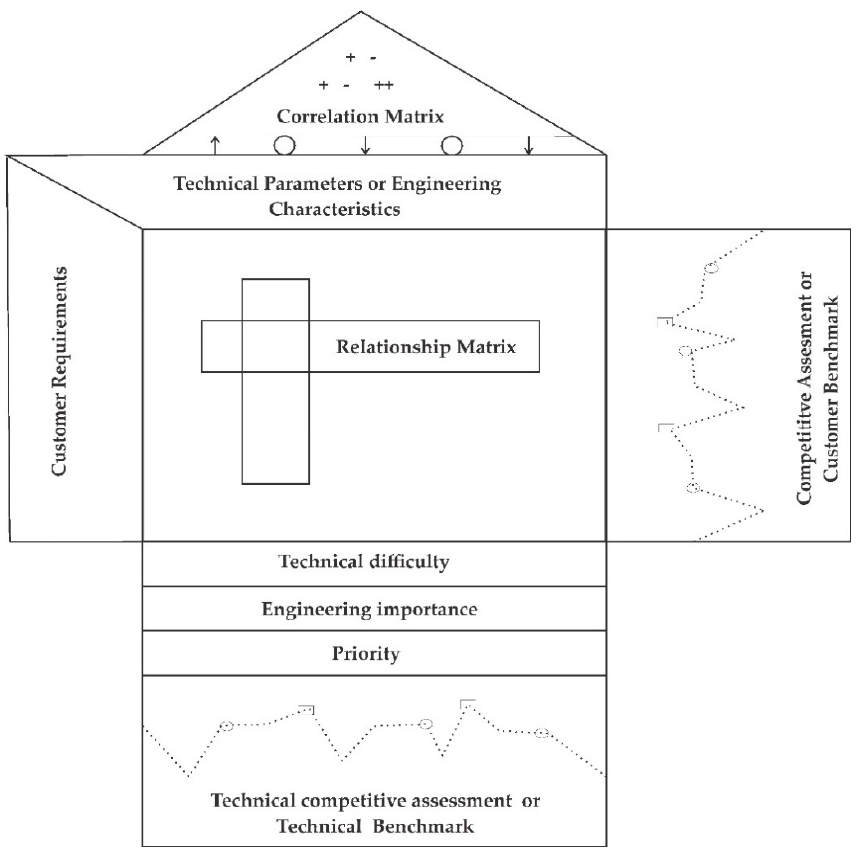
Figure 2. House of Quality (HoQ) and components.